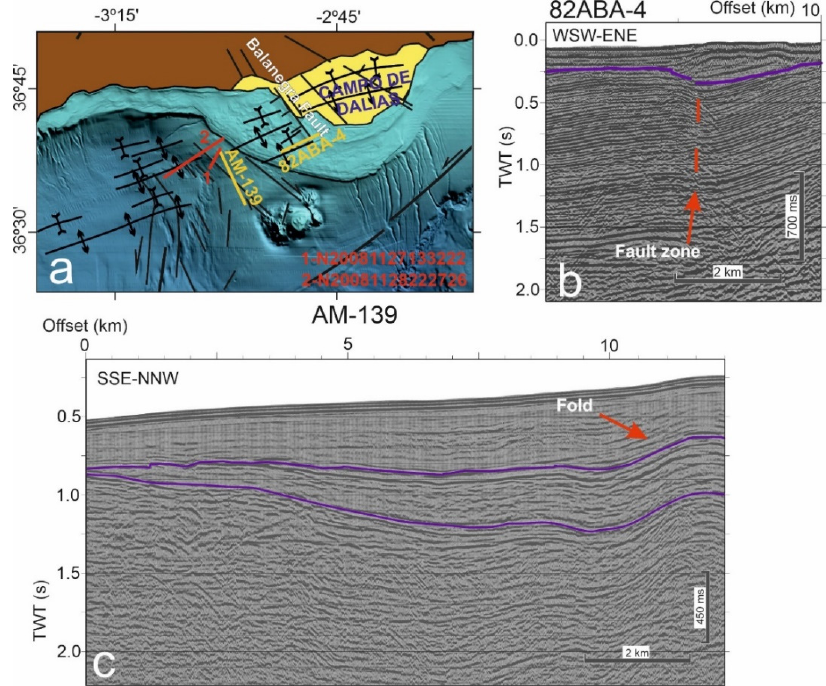
Figure 4. Seismic reflection profiles offshore of the Campo de Dalias: ( a ) Location of the profiles on the regional sketch of the main tectonic structures. ( b ) Profile 82 ABA-4, at the southern tip of the Balanegra Fault. ( c ) Profile AM-139, orthogonal to the east-northeast–west-southwest folds.